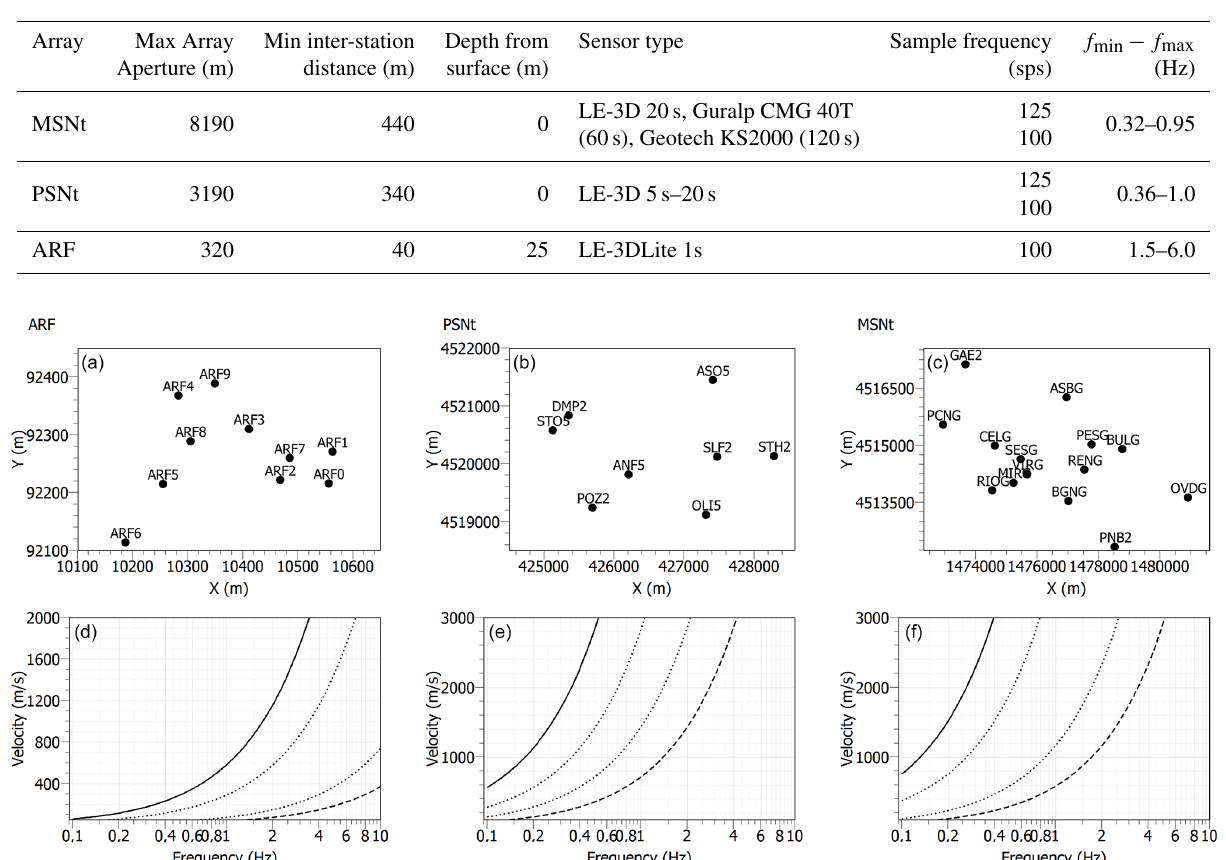
spectral ratio calculated in different periods of the year 2011 as well as in 2012 (for the available 3-component stations) shows no difference, indicating that the spectral ratios rela- tive to January 2011 are stable in